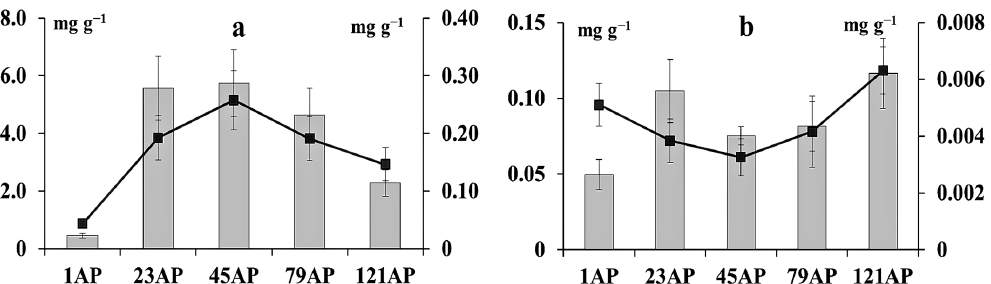
Figure 6. Water soluble organic matter at organic ( a ) and E pyr ( b ) horizons. Columns—water soluble organic carbon (WSOC) on the left scale; line—water soluble organic nitrogen (WSON) on the right scale.